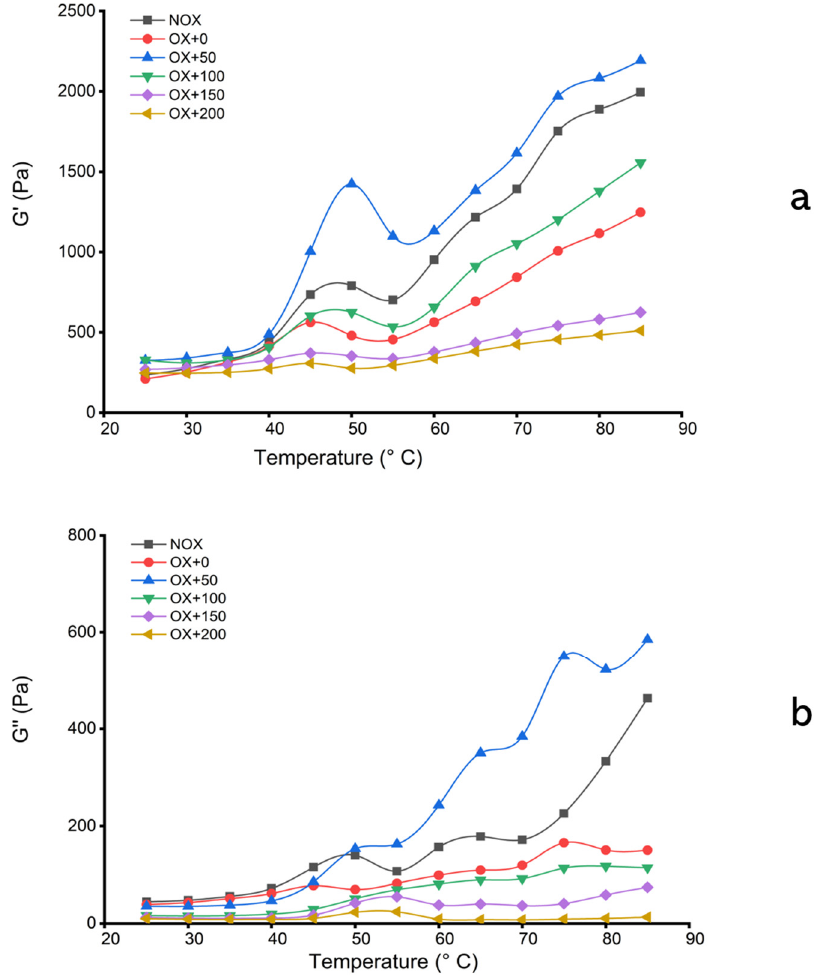
Figure 3. G’ ( a ) and G” ( b ) of MP solutions during gelation (25–85 ℃ ) affected by oxidative stress with or without FOs. NOX, nonoxidized; OX, oxidized; OX + 0, OX + 50, OX + 100, OX + 150, and OX + 200: oxidized in the presence of FOs at 0, 50, 100, 150, and 200 μ mol/g protein,